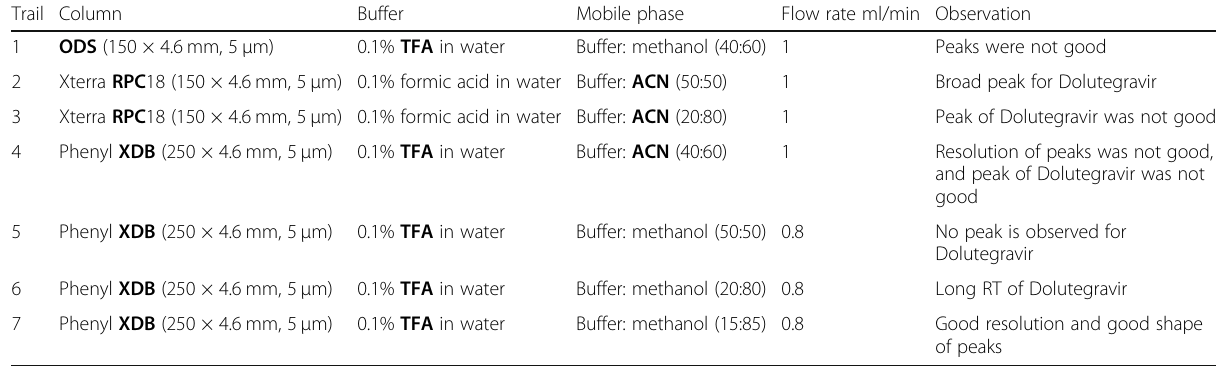
Table 1 Different trials Trail